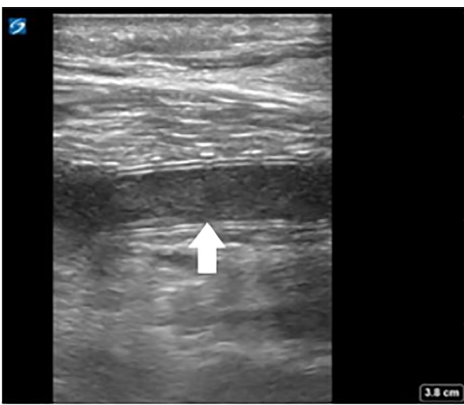
Image 5a. Longitudinal view of patient’s femoral-posterior tibial graft (arrow) demonstrating echogenic thrombus